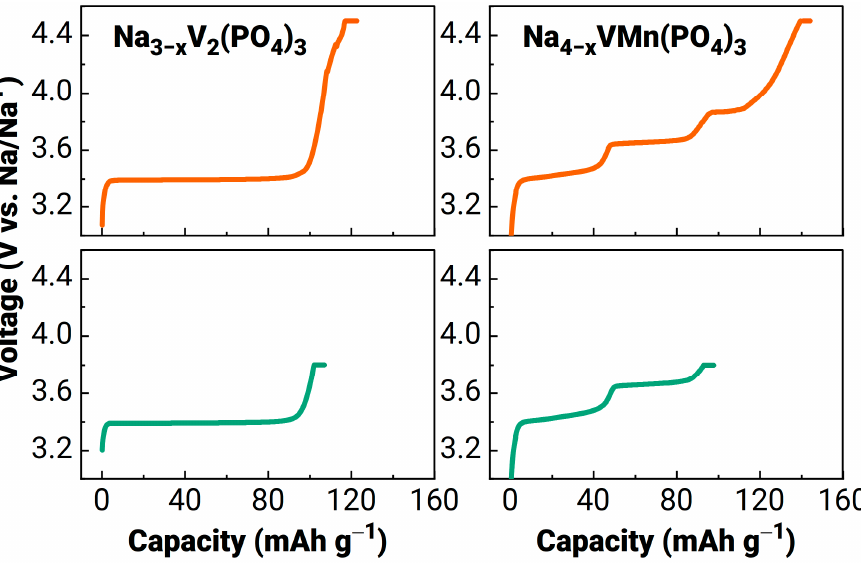
Figure 2. Charged curves of Na 3 V 2 (PO 4 ) 3 and Na 4 VMn(PO 4 ) 3 cathode materials at different potential cut-offs (3.8 V on the bottom and 4.5 V on the top ).